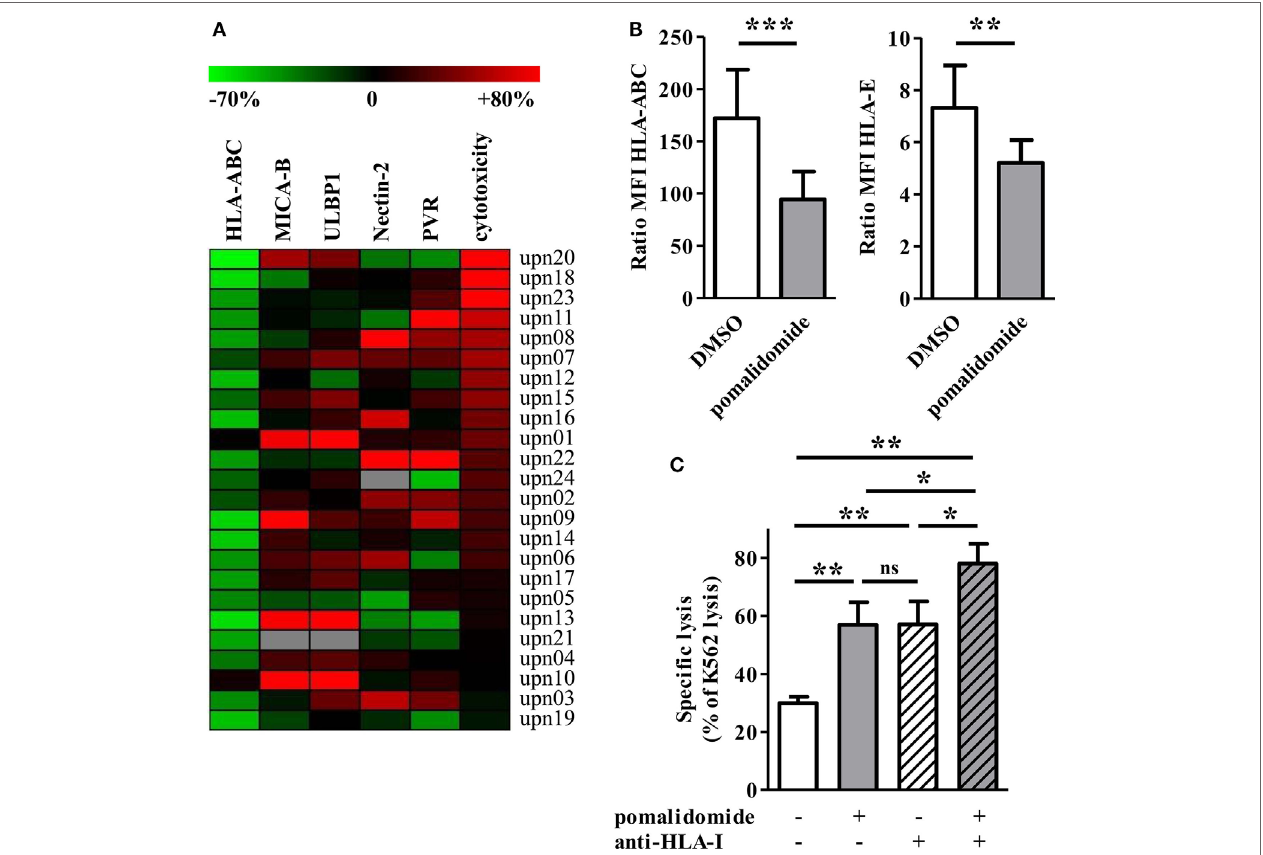
FigUre 5 | Pomalidomide induces downregulation of MHC class I and change of the expression of natural killer (NK) cell ligands on acute myeloid leukemia (AML) blasts. (a) The expression of surface markers and cytotoxicity in the pomalidomide condition are represented relatively to the DMSO condition. The relative variation ranges from − 70% (green) to + 80% (red). The heatmap is sorted according the cytotoxicity level (rightmost column). HLA-ABC is clearly decreased for the majority of the samples. (B) The expression of HLA-ABC and HLA-E are represented in the DMSO and pomalidomide conditions on the left and right graphics, respectively ( n = 24). Results were expressed as mean ± SEM and statistical significance was established using Wilcoxon matched pairs test. (c) Comparison of the sensitivity of AML blasts ( n = 3) to allogeneic NK cells ( n = 2–4), after treatment of AML blasts with pomalidomide or DMSO control and then incubation with anti-HLA-I-blocking mAbs or isotype control mAbs. Data are shown for E:T 15:1. Results were expressed as mean ± SEM and statistical significance was established using Wilcoxon matched pairs